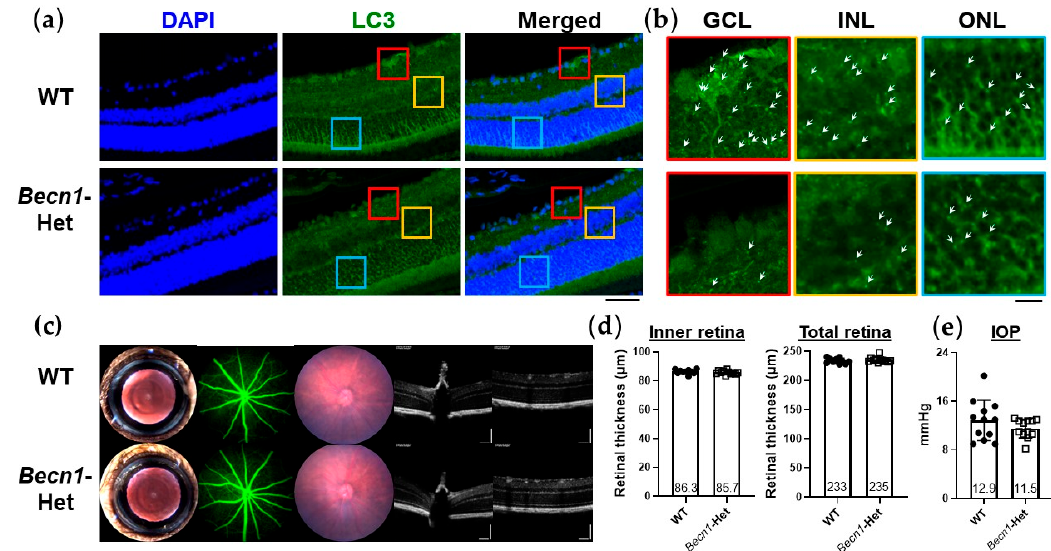
Figure 2. Retinal autophagic dysfunction and ocular phenotypes of beclin1-heterozygous mice ( Becn1 -Het). ( a ) Immunofluorescence staining of LC3 in the retina of wild-type (WT) and Becn1 -Het mice (each image is representative of 2 eyes). Immunofluorescence staining was performed on 5 µm thick retinal cryosections of WT and Becn1 -Het mice, and images were acquired with confocal microscopy. Representative merged z-stack images are shown. The scale bar shows 50 µm. ( b ) Enlarged images of LC3 immunostaining in the ganglion cell layer (GCL), inner nuclear layer (INL), and outer nuclear layer (ONL). Red, yellow, and blue colors correspond to the respective area of the images shown in ( a ). White arrow heads indicate visible LC3 punctae. The scale bar shows 10 µm. ( c ) Representative clinical imaging of the eyes of WT and Becn1 -Het mice, including (from left to right), slit lamp photography, fundus fluorescein angiography, fundus photography, and spectral domain ocular coherence tomography (OCT). ( d ) Inner and total retina thickness was quantified based on the OCT images obtained. Image quantification was performed on ImageJ. The inner retina is defined to include the GCL, IPL (inner plexiform layer), and INL, whereas the total retina includes all retinal layers. N = 10–12 eyes from 5–6 mice per each group. ( e ) Intraocular pression (IOP) measured with rebound tonometer in WT and Becn1 -Het mice. The same mice shown in ( d ) were used for IOP measurements. Each value represents the mean ± standard deviation with the mean value indicated at the bottom of each bar. Statistical analysis was performed with an unpaired t -test.